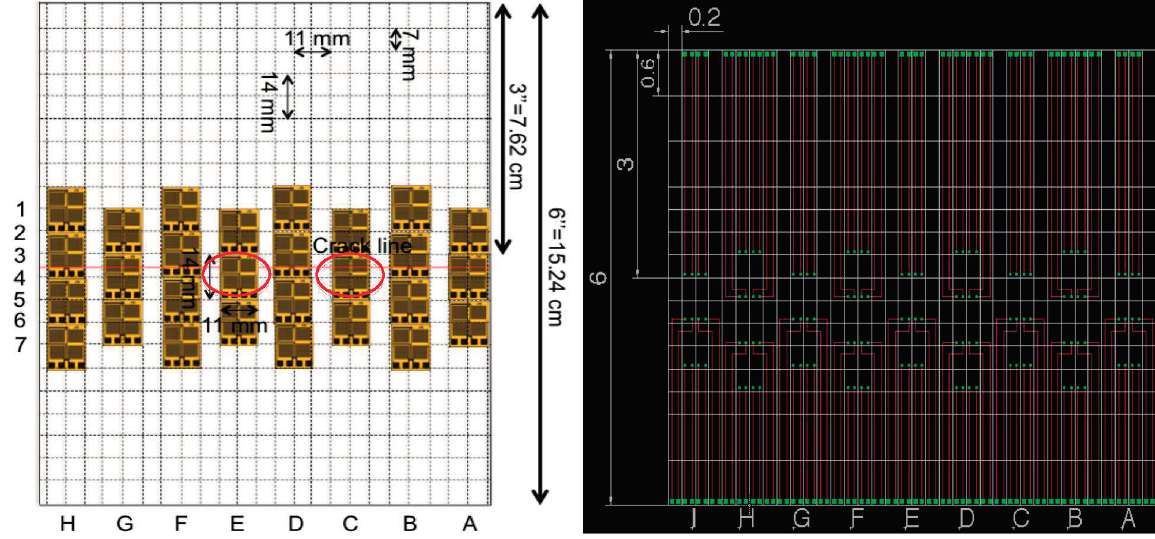
Figure 6. ( Left ): Scheme of sensing sheet Design 1; ( Right ): Corresponding EAGLE PCB Design.